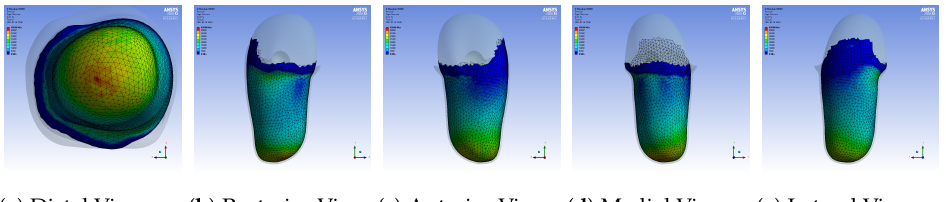
Figure 9. Pressure distribution over the entire stump after the donning process with the nomi- nal socket.